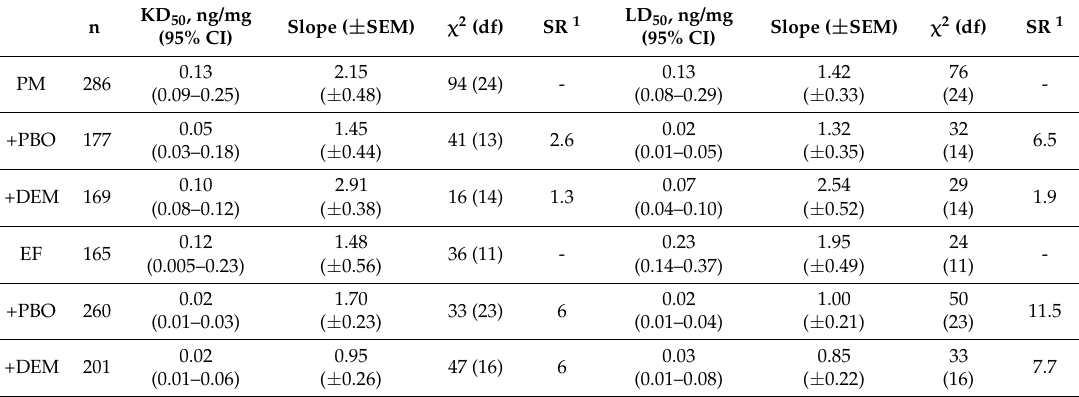
Table 4. Toxicity and synergism of permethrin (PM) and etofenprox (EF) An. gambiae (Strain G3).